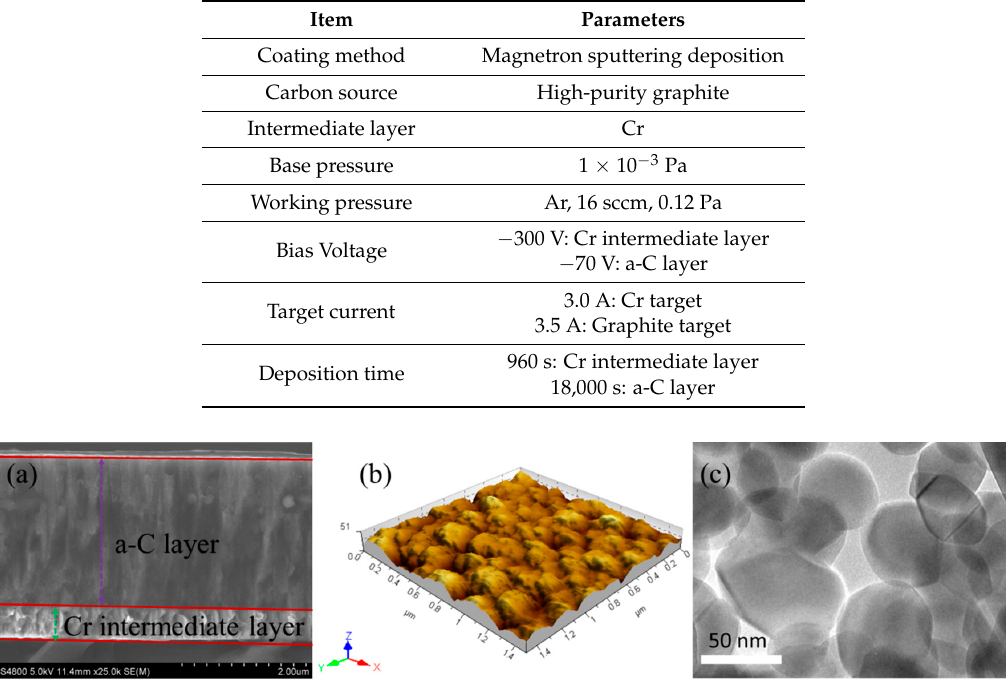
Figure 1. ( a ) The cross-sectional morphology; and ( b ) the surface topography of as-deposited a-C coating; and ( c ) the TEM micrographs of used ZrO 2 -NPs.